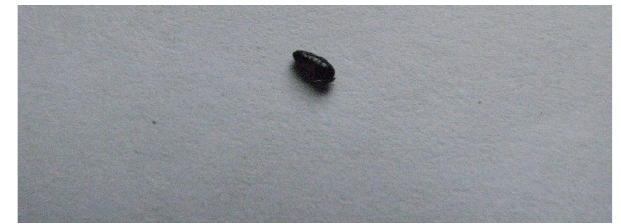
Fig. 8. Pupa of Acanthiophilus helianthi Rossi